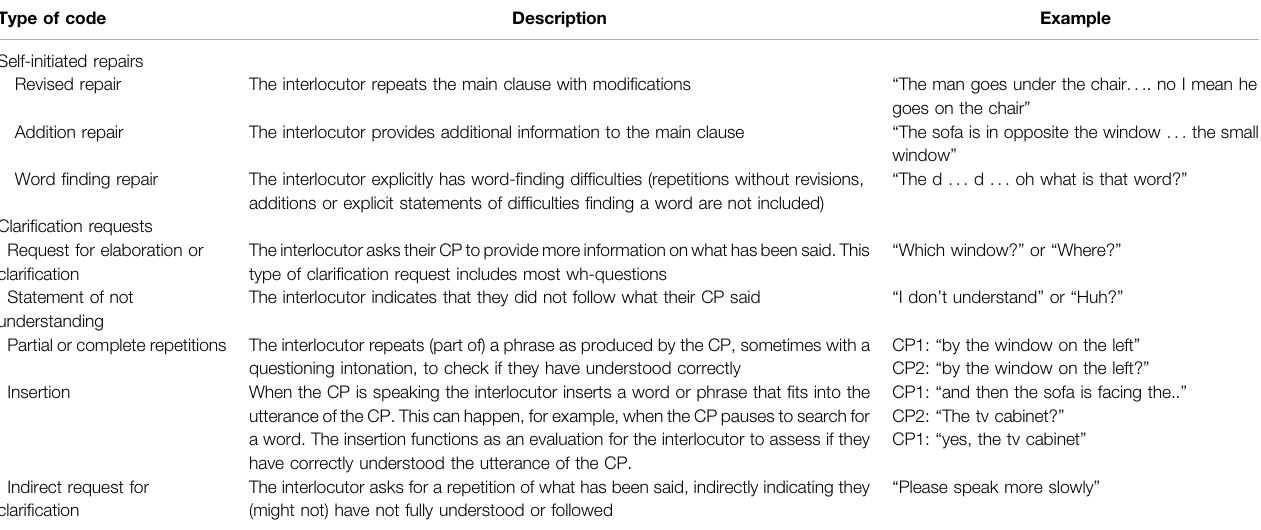
TABLE 1 | Different types of self-initiated repairs and clari fi cation requests that were